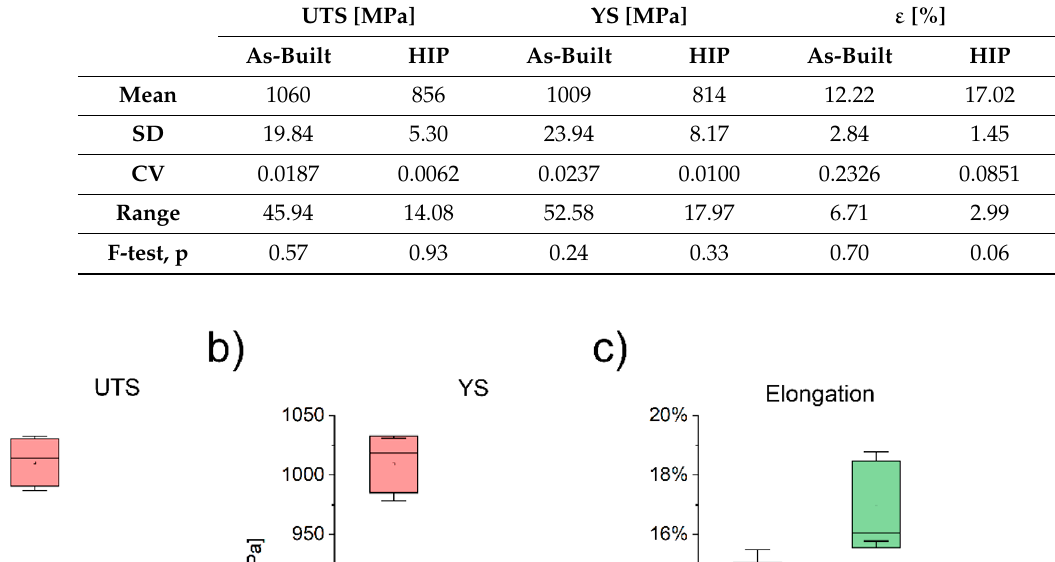
Table 5. Strength properties of the PBF-EB/Ti-55511 specimens in the as-built and HIP state.